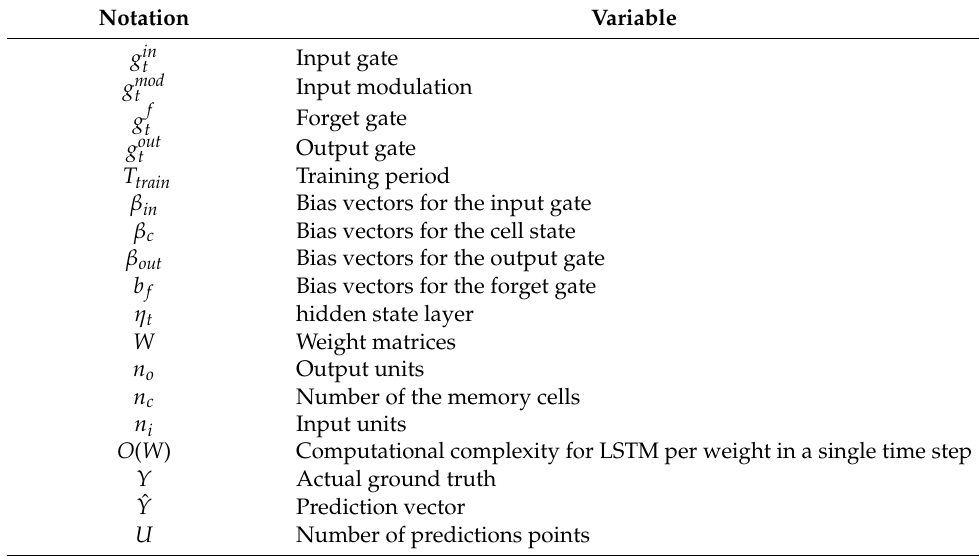
Table 5 for a complete list of notations for the LSTM deep learning network. Table 5. List of notations for the LSTM